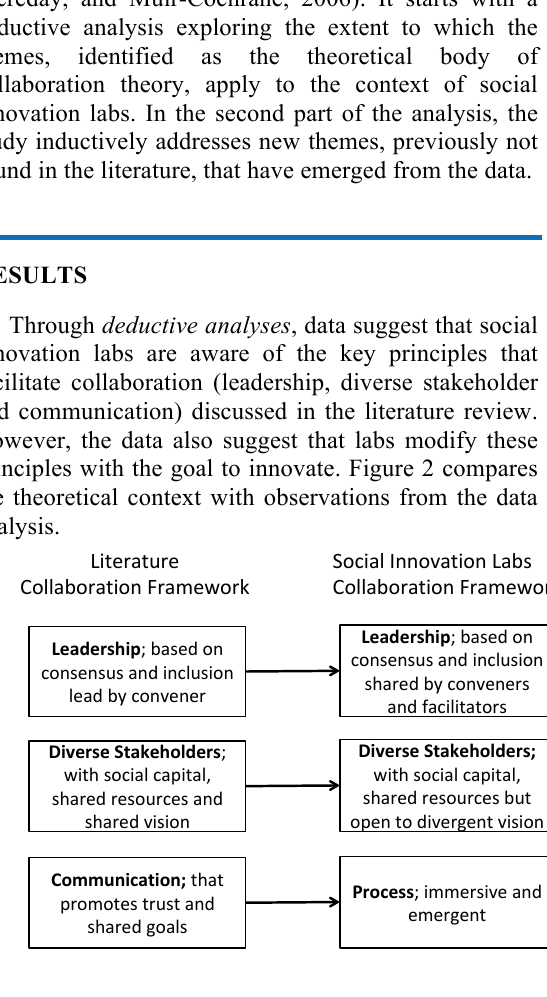
Fig. 2: Comparison of collaboration framework from literature with that of social innovation labs